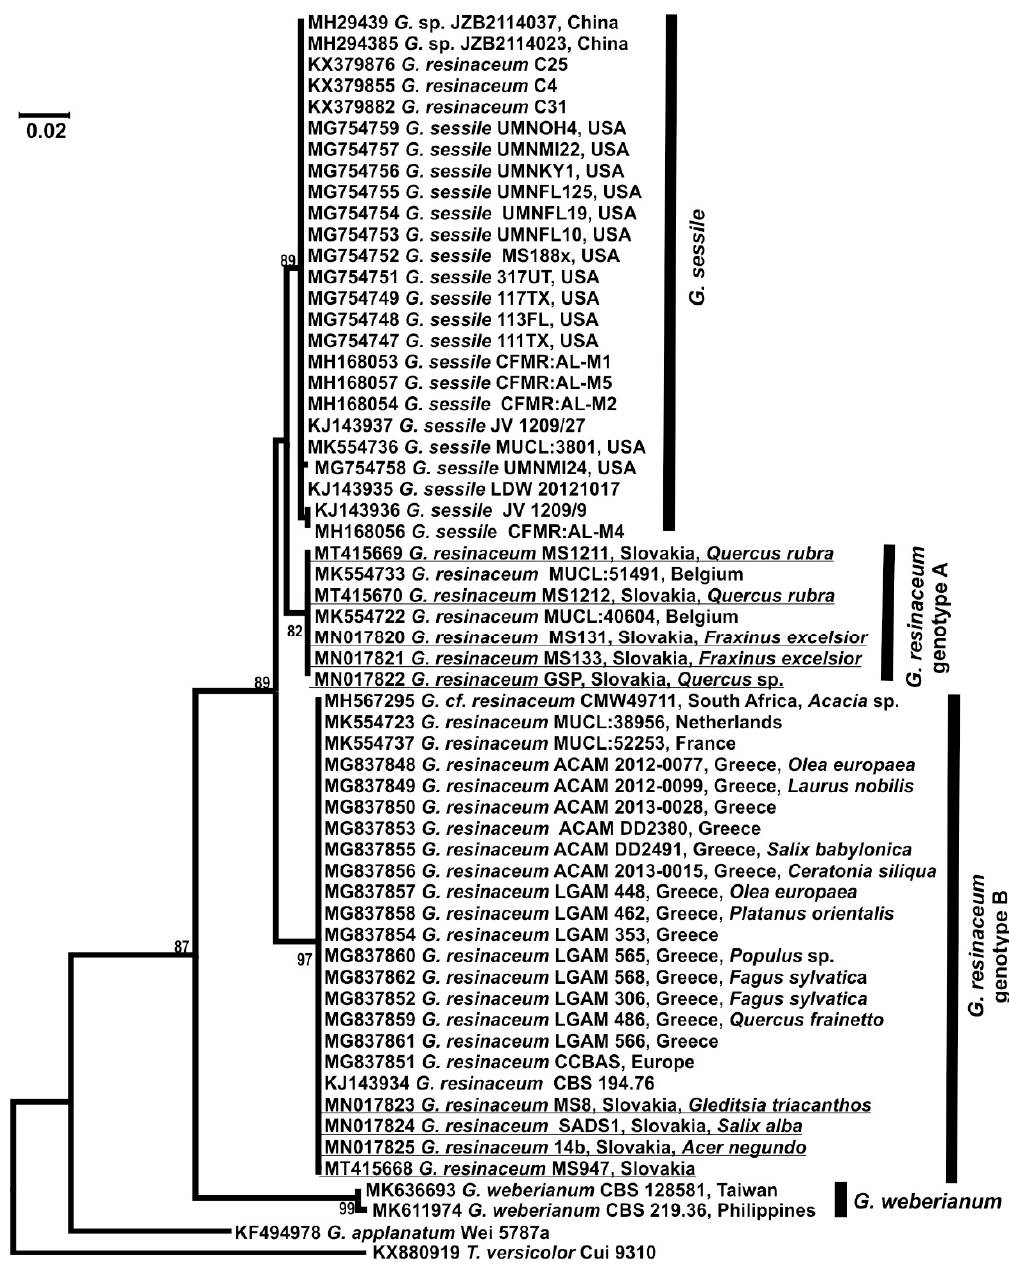
Figure 3. Genetic diversity between Ganoderma resinaceum genotypes documented by tef1- α sequence analysis. Maximum parsimony phylogenetic tree documenting phylogenetic relatedness of Ganoderma resinaceum specimens from Slovakia based on tef1- α region sequences comparison. The sequences obtainedthroughthisstudyareunderlined. Numbersatnodesarebootstrapvaluesafter1000repetitions (only values over 80 are shown). Tef1- α sequence of Trametes versicolor (GenBank accession number KX880919) was used as an outgroup. The bar indicates the number of nucleotide changes over the whole